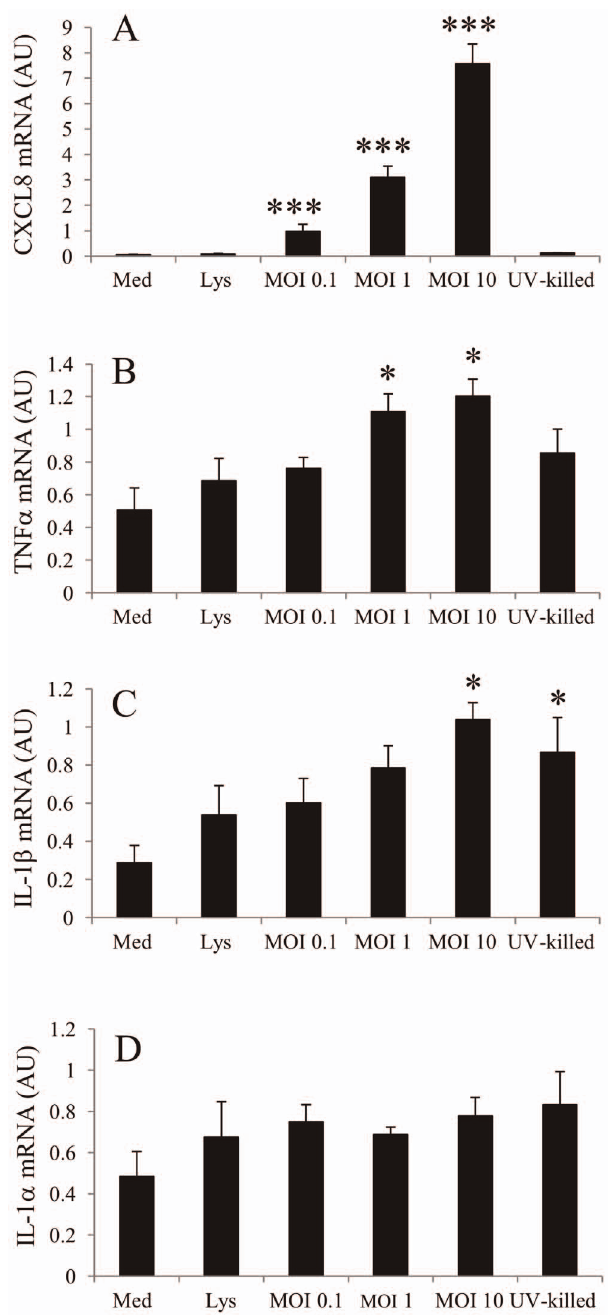
Figure 4. Changes in the expression of A) CXCL8, B) TNF- a , C) IL-1 b , D) IL-1 a mRNA after exposure of AH-1 trophoblast cells to medium alone (Med), uninfected control cell lysate (Lys) or increasing MOI of W.chondrophila (MOI 0.1, 1, 10) or UV-killed organisms (MOI 10) for 24 h. Statistically-significant differences relative to medium control are indicated by *P , 0.05; ***P , 0.001. Data were analysed by two-way ANOVA. Comparisons between individual treatments were made using Tukey’s multiple comparison test (n=3). Data are presented as arbitrary units (AU).